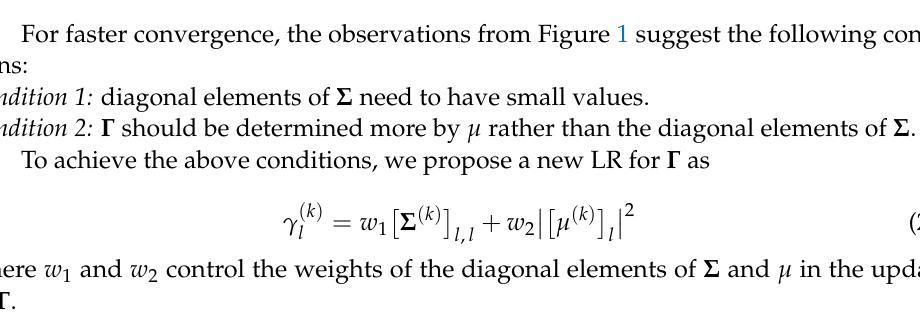
Figure 1. Exemplary CIR and µ , Σ , and Γ at the first, second, and fifth